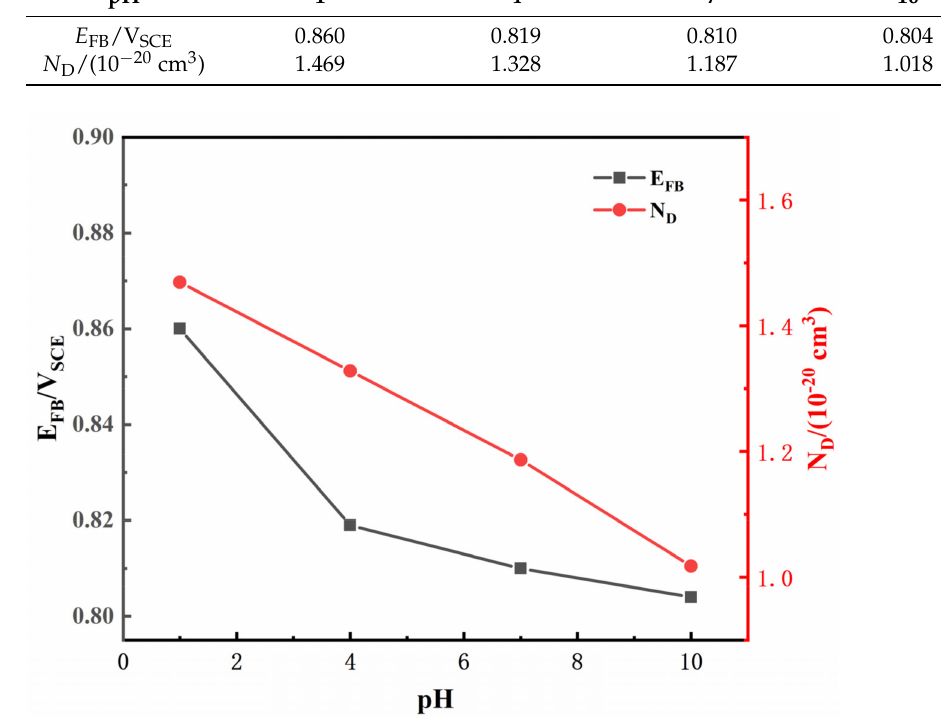
Figure 6. Variations in E FB and N D as a function of